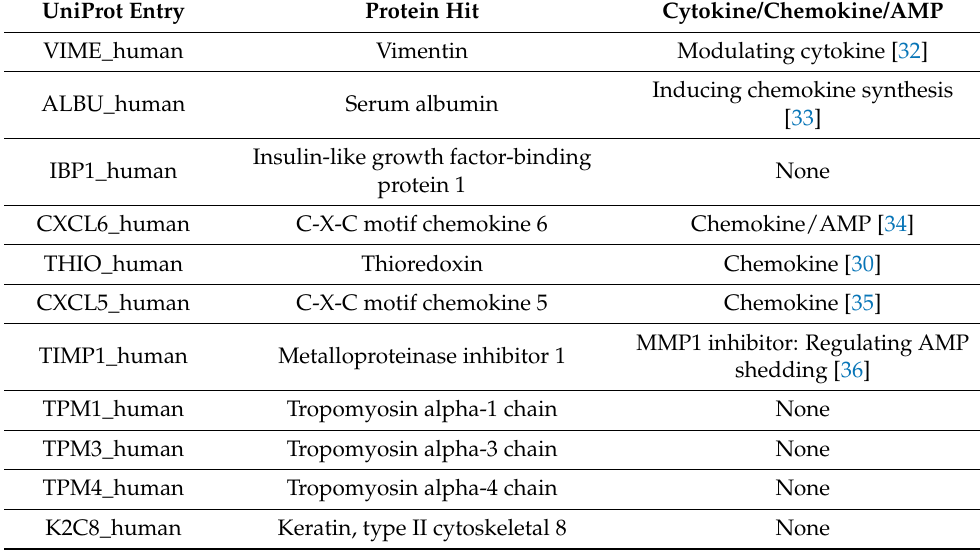
Table 1. Shot-gun proteomic analysis of a panel of cationic polypeptides in a culture medium of REC. A549 cells, a type II alveolar epithelial cell line from human adenocarcinoma, were